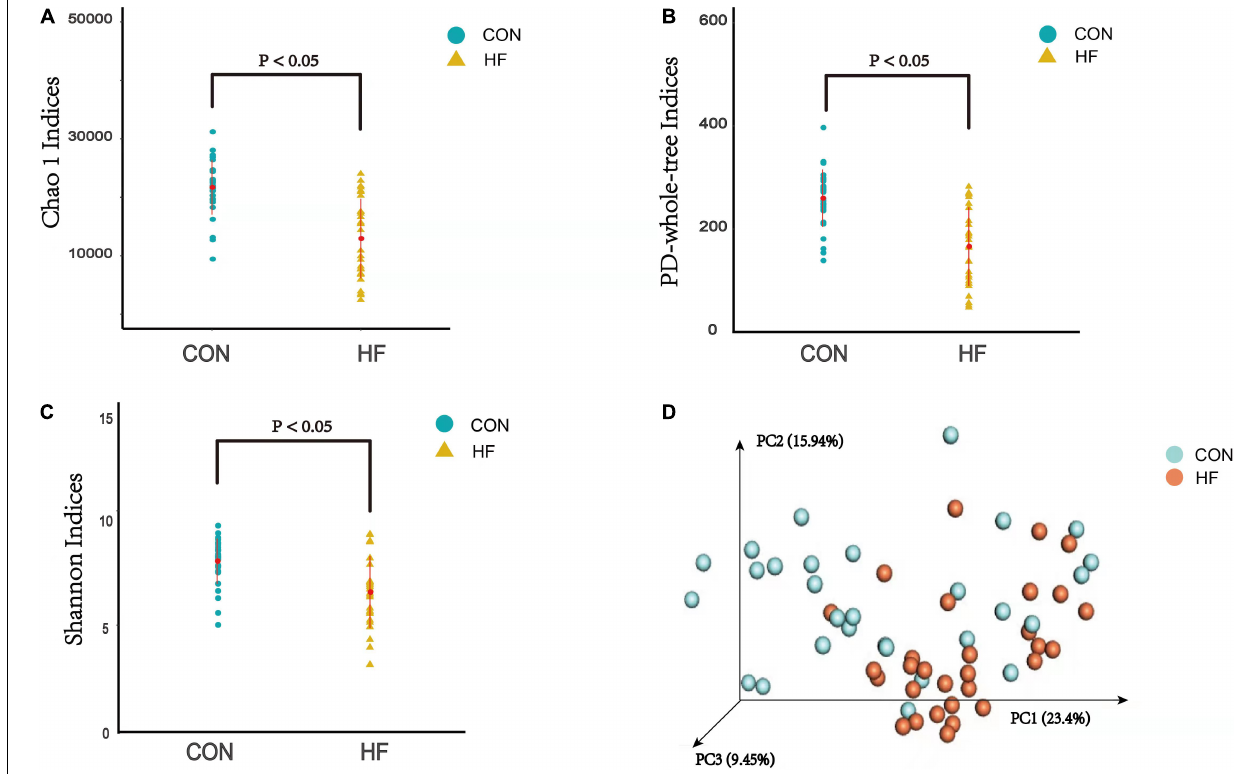
FIGURE 2 | The α -diversity indices and the β -diversity of the gut microflora between the CHF group and the healthy control group. (A) PD-whole tree indice; (B) Chao1 indices; (C) Shannon indices; (D) β -diversity based on the weighted UniFrac. HF, CHF group; CON, the healthy control